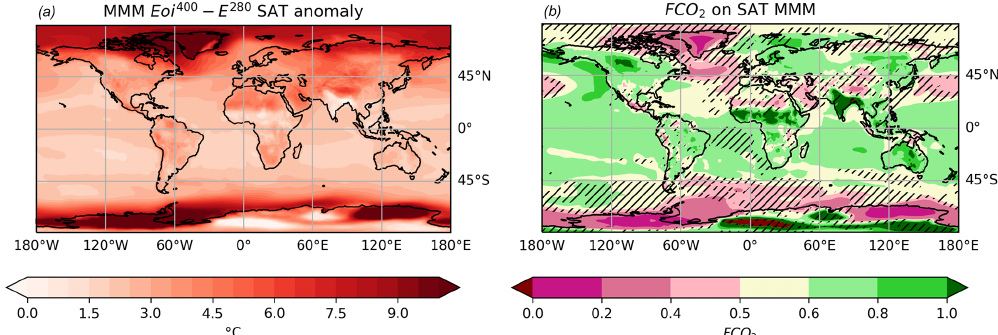
Figure 4. MMM Eoi 400 minus E 280 SAT anomaly (a) and FCO 2 of the MMM for SAT (b) . The hatching in (b) represents where there is no consistent agreement between models on whether CO 2 forcing or non-CO 2 forcing is the most important (i.e. whether FCO 2 > 0 . 5 or FCO 2 < 0 .